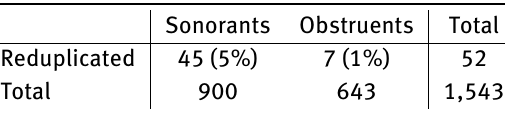
Table 1: The numbers of sonorants and obstruents targeted by reduplication in AKB idol